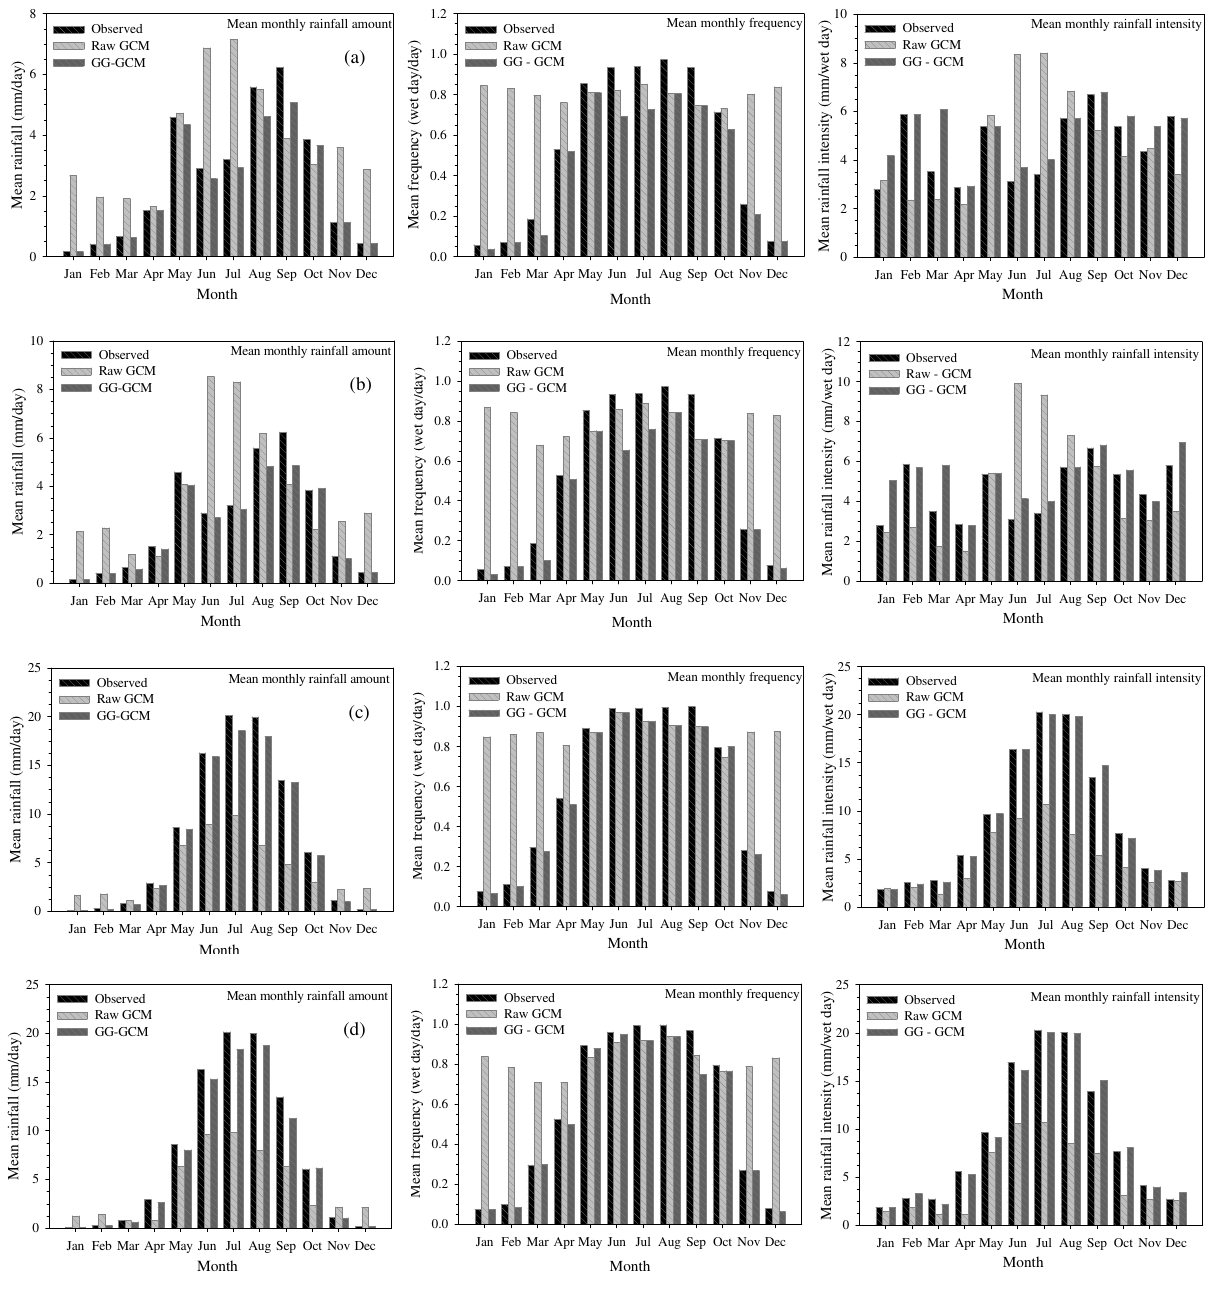
Fig. 6. Comparison of observed, raw GCM and bias-corrected GCM scenarios (a) grid 1-A2, (b) grid 1-B2, (c) grid 2-A2, and (d) grid 2-B2.